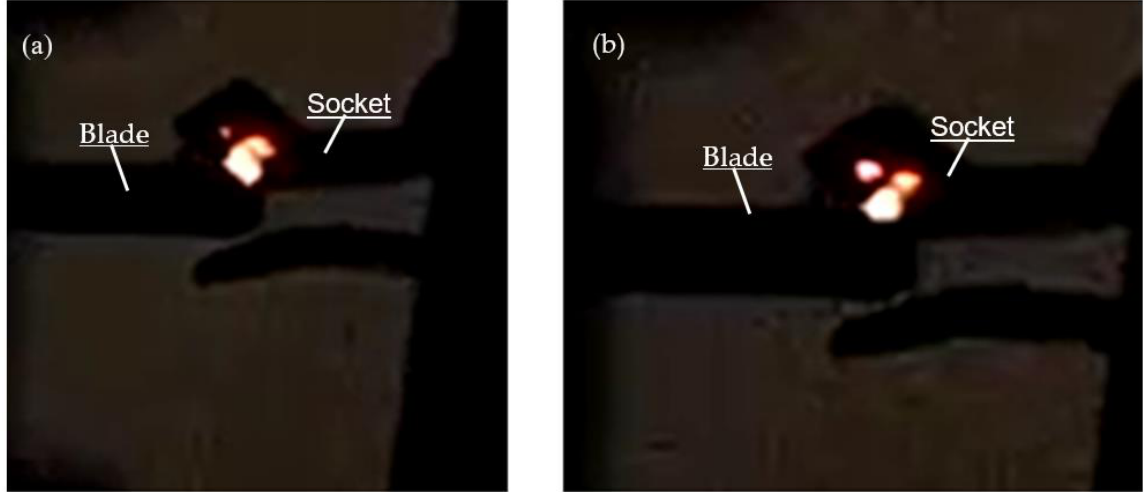
Figure 3. Pictures of a typical arc-fault state. ( a ) The arcing state between the copper and brass contacts when it is at its lowest energetic state near the zero-crossing point of the current. ( b ) The arcing state 10 ms later when the arc is at its most energetic state and is much more prominent.